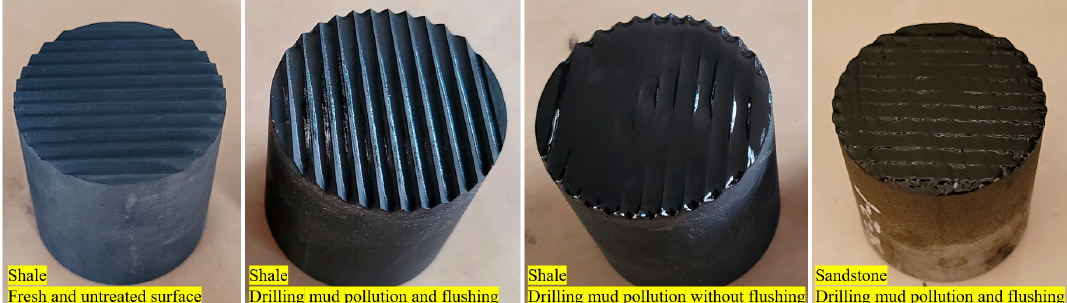
Figure 5. Rock surface state with different treatment method.